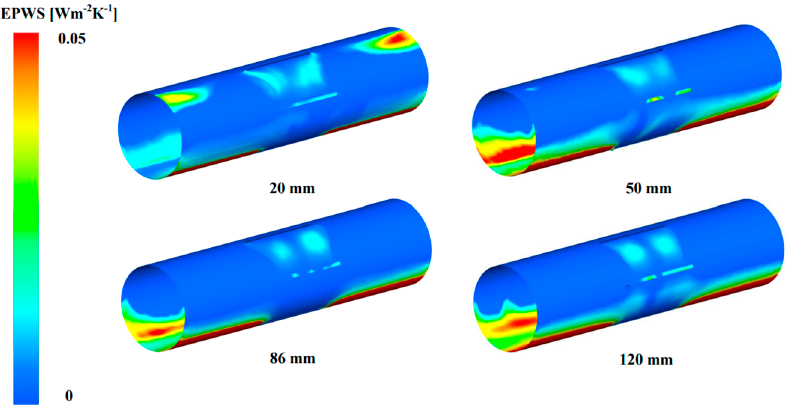
Figure 15. Distribution of EPWS in the hub of water wheels under different clearance configurations. Figure 16 delineates the EPWS distribution of blades under different clearances of water wheels. The overall distribution law of EPWS is similar under different clearances.